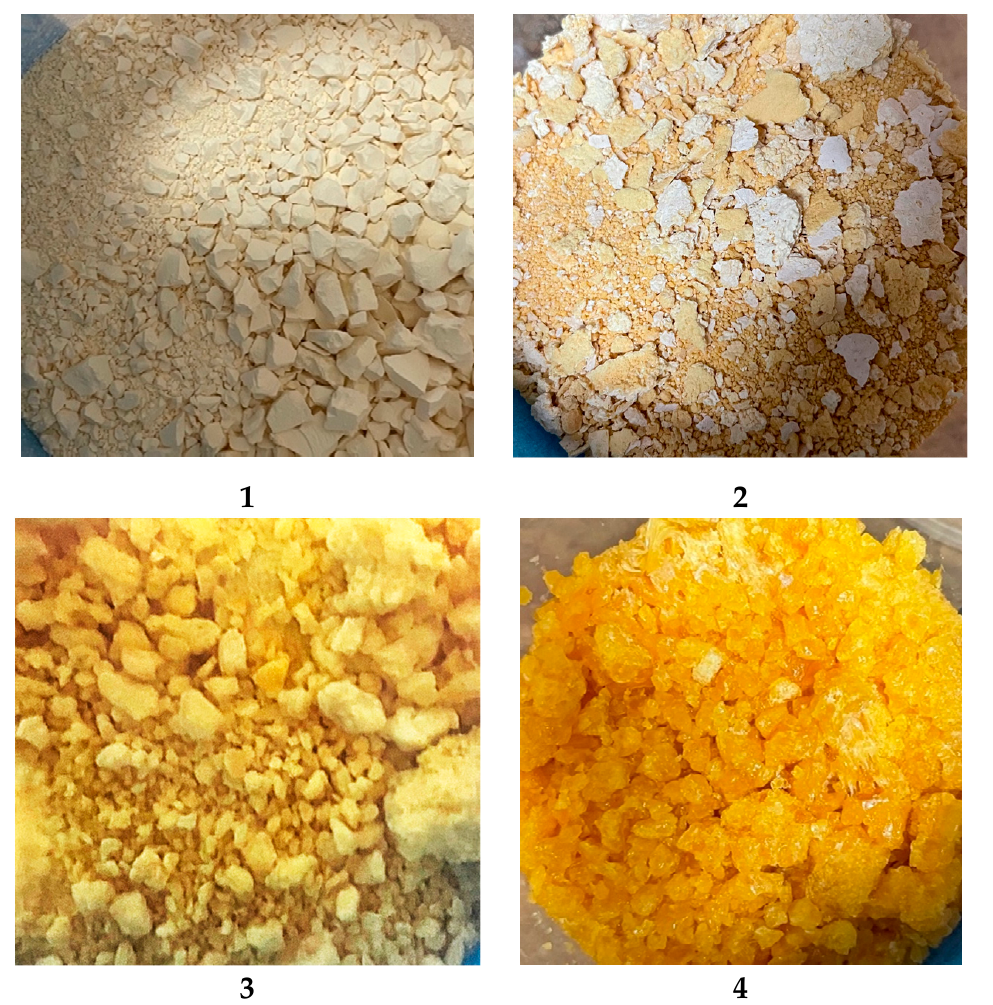
Figure 2. Samples of PVA 1–4 showing the texture and consistency characteristics, as well as color- ing.